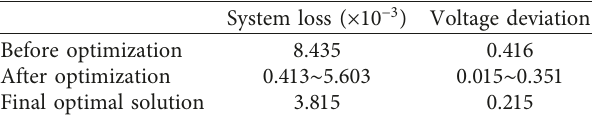
Table 10: Comparison of the optimization index.